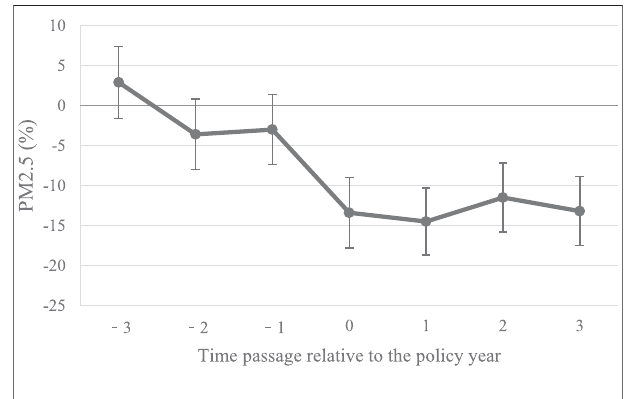
FIGURE 12 | The parallel trend test for the PM 2.5